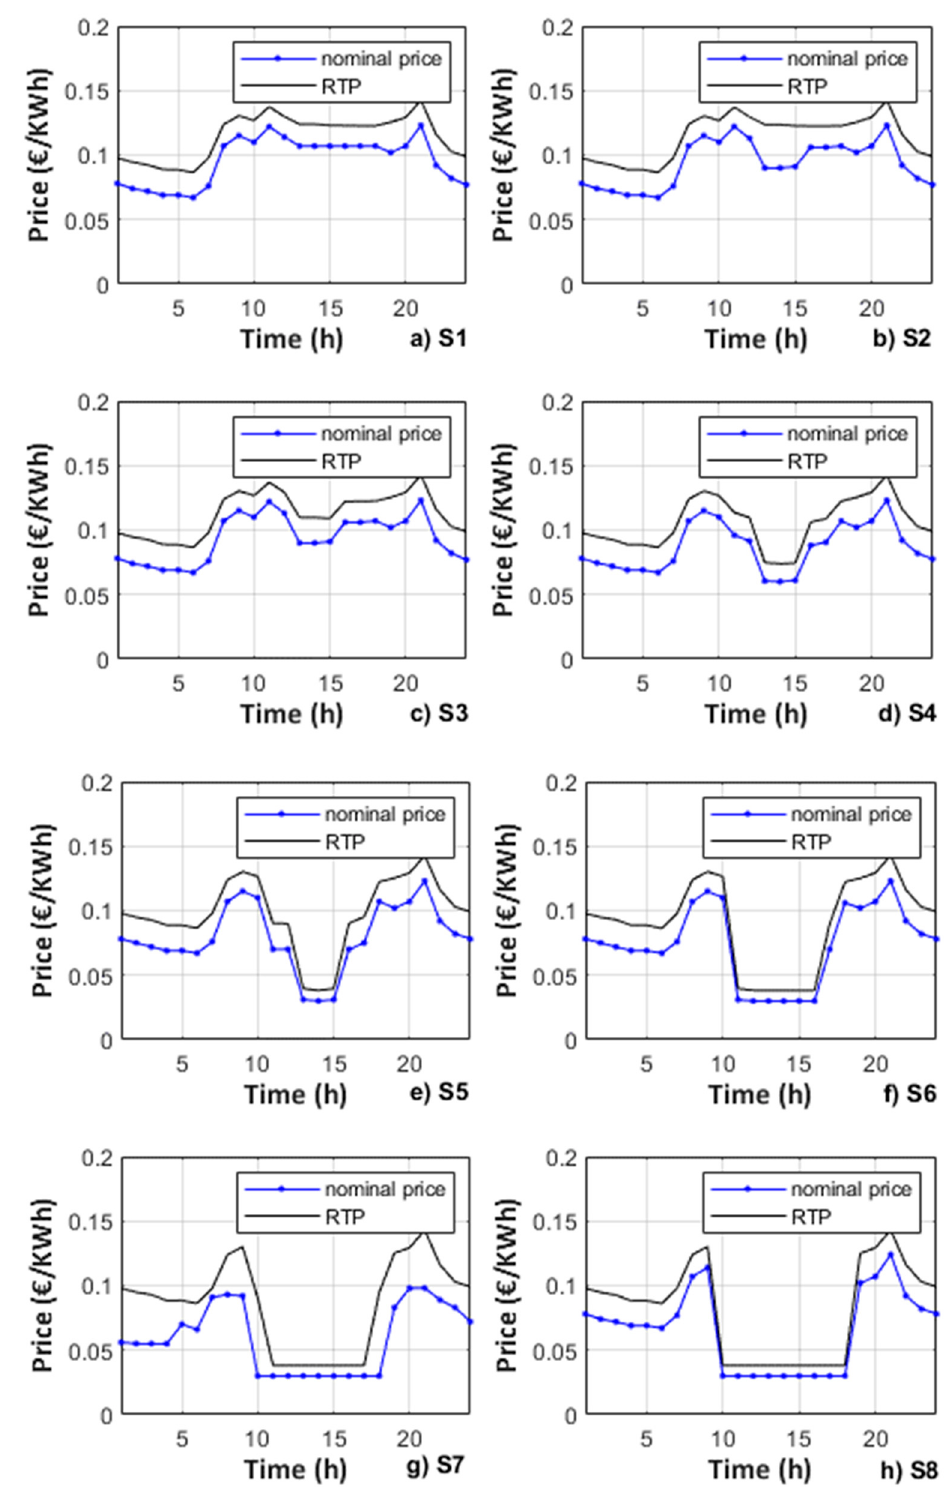
Figure 6. Nominal price and RTP corresponding to day 16 August 2019 for: ( a ) S1, ( b ) S2, ( c ) S3, ( d )